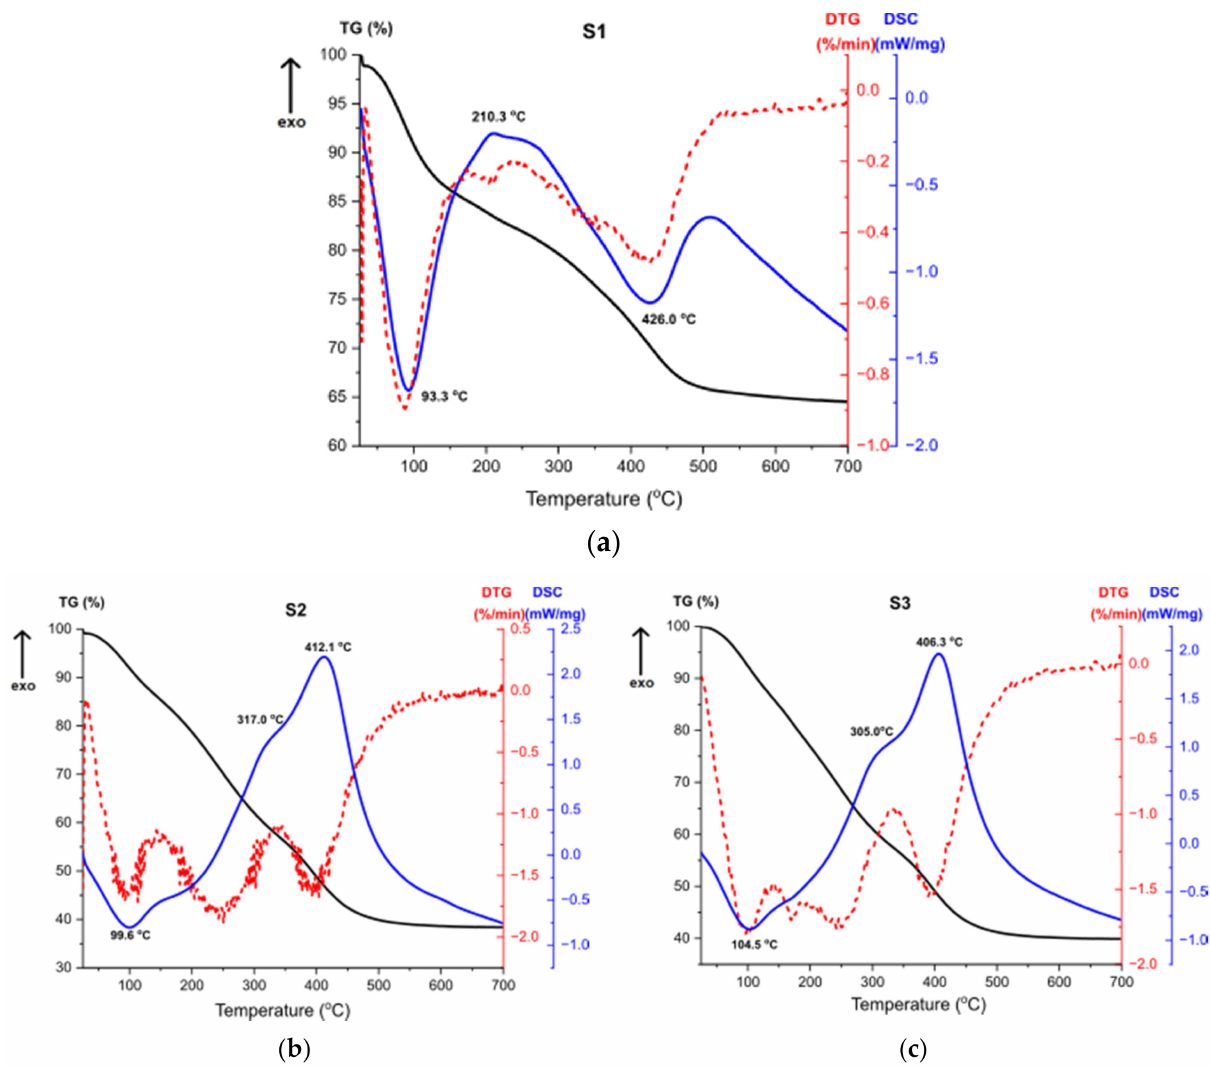
Figure 11. TG, DTG, DSC curves for the samples ( a ) S1, ( b ) S2, ( c )